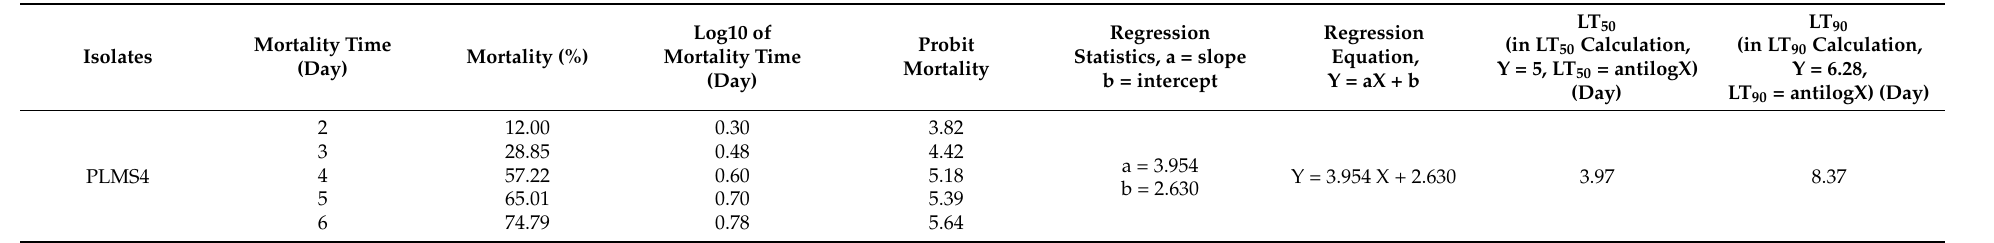
Table 5. LT 50 and LT 90 values for the efficacy of the isolates against SWA adults, using mortality of different times (2 to 6 days) at 1 × 10 8 conidia mL − 1